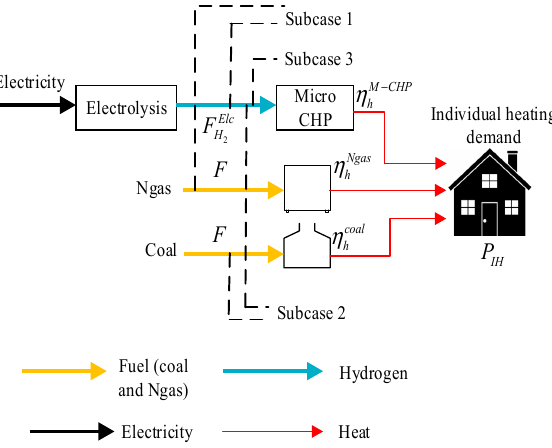
Figure 8. Coal, Ngas and H2 micro CHP are used to meet individual heating demand.